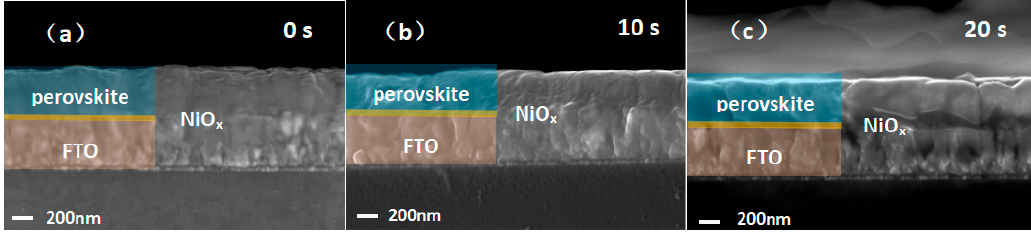
Figure 3. Evolution schematic diagram of organic–inorganic hybrid perovskite morphology with different annealing conditions.